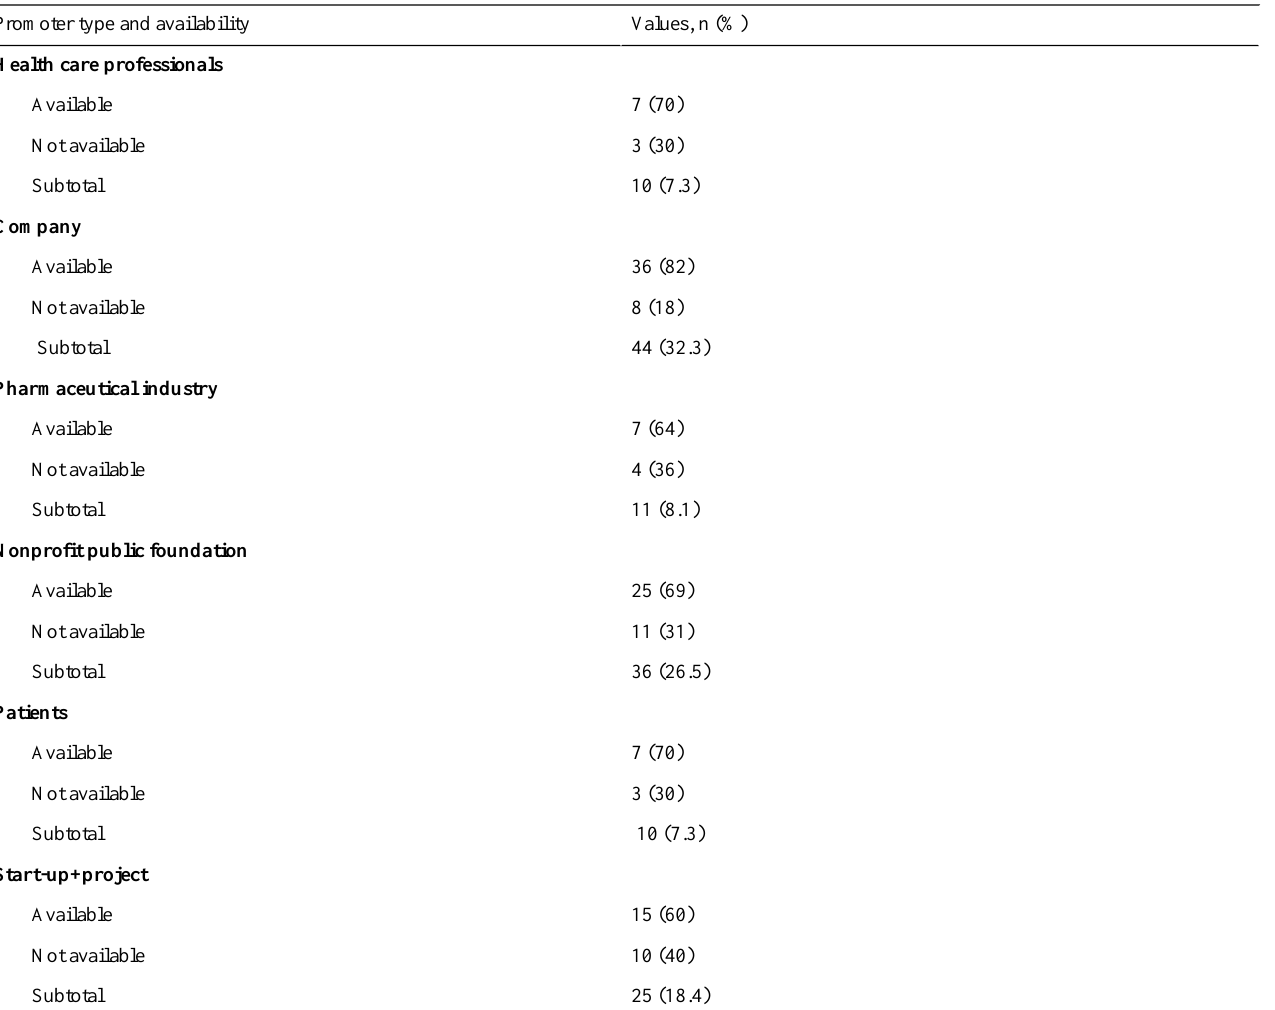
Table 7. Apps selected and classified by promoter